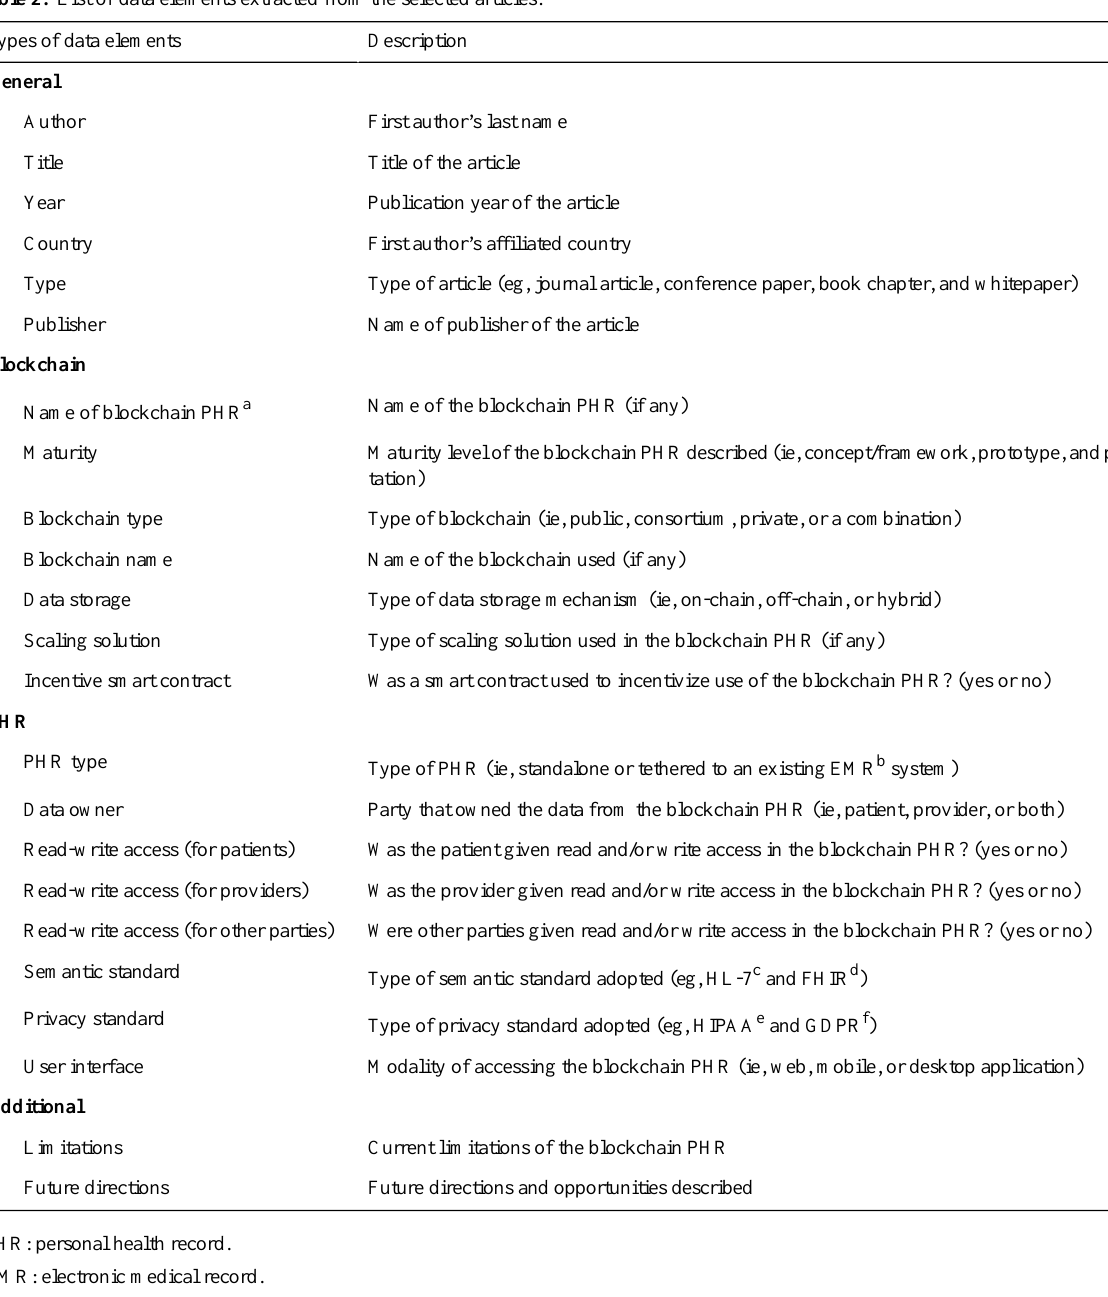
Table 2. List of data elements extracted from the selected